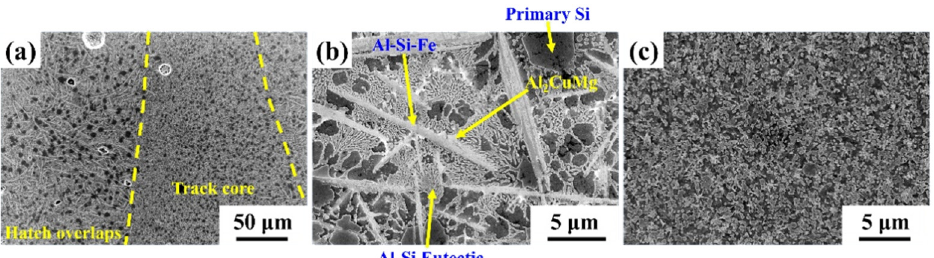
Figure 1. Scanning electron microscopy images of the SLM fabricated Al-20Si-5Fe-3Cu-1Mg alloy: ( a ) low magnification image showing the presence of hatch overlaps and track cores, ( b ) hatch overlaps showing the phases: primary Si, Al-Si-Fe, Al 2 CuMg, and Al-Si eutectic, and ( c ) track cores showing fine morphology of the phases.